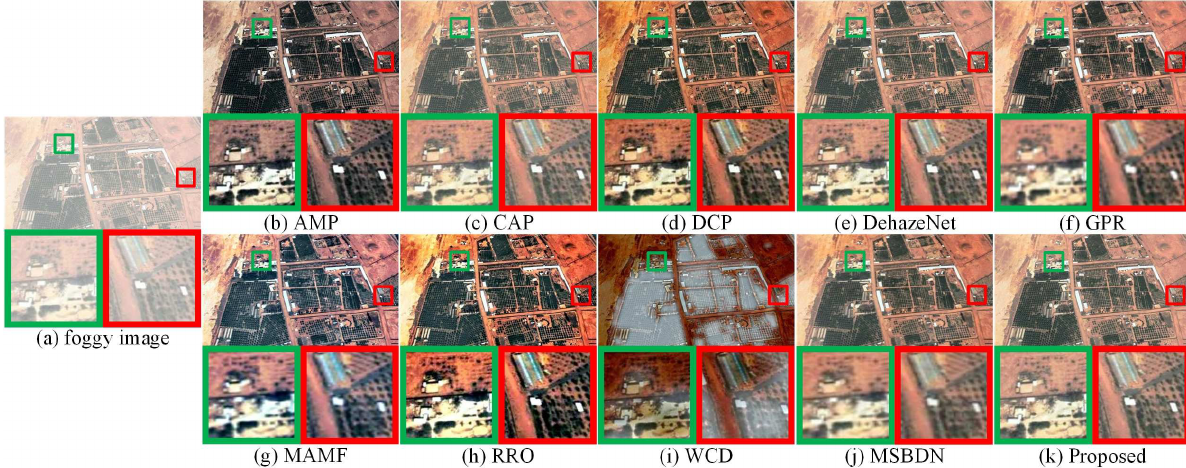
Figure 8. ( a ) shows a synthetic foggy remote sensing image. ( b – k ) respectively represent the defogged images obtained by AMP, CAP, DCP, DehazeNet, GPR, MAMF, RRO, WCD, MSBDN, and the proposed method. The two partially enlarged images marked in the green and red frames correspond to two areas enclosed by the green and red frames in each defogged